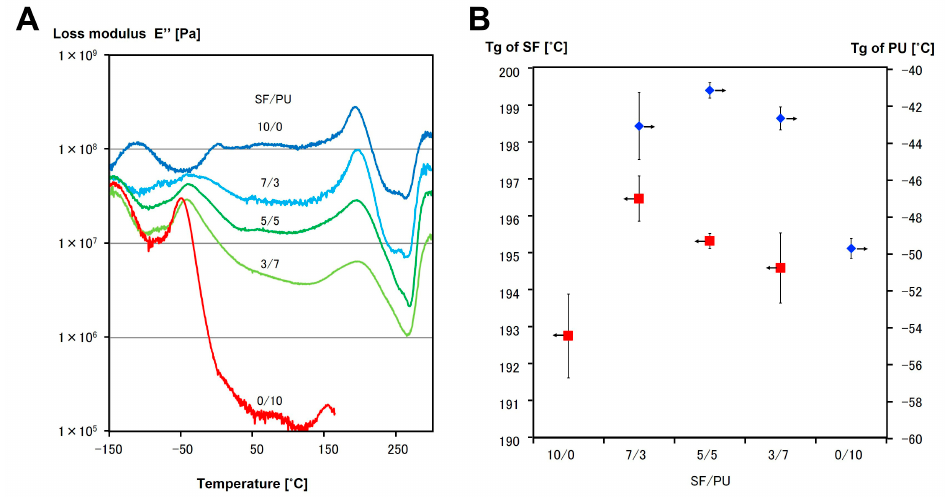
Figure 6. The loss modulus ( E ″ ) ( A ), and the glass transition point ( T g ) read from E ″ curve ( B ) of SF/PU = 10/0, 7/3, 5/5, 3/7 and 0/10. SF/PU = 10/0, 7/3, 5/5, 3/7 and